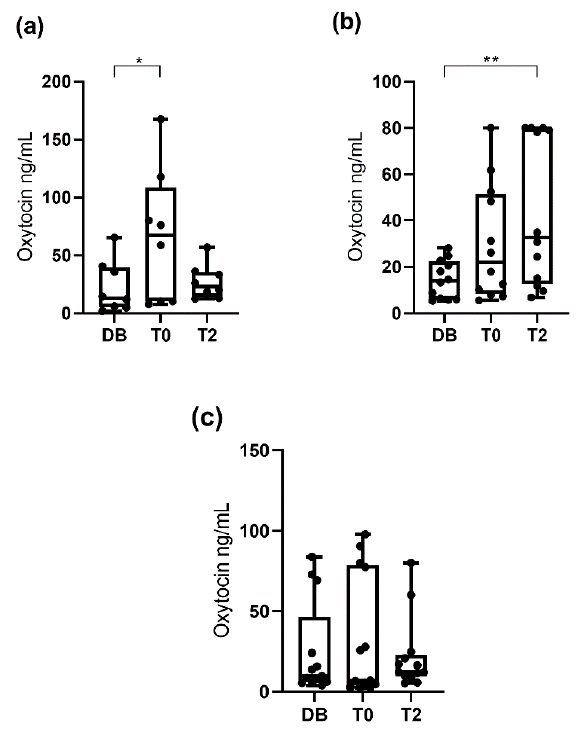
Figure 5. Changes in salivary oxytocin concentrations measured with AlphaLISA polyclonal assay at different times: the day before ejaculate collection (DB), immediately after starting the ejaculation (T0), and two hours after ejaculation (T2). Figure ( a ) shows the data for boars aged 12–24 months and ( b ) and ( c ) those for boars aged 24–36 and aged more than 36 months, respectively. The plots show medians (line within box), 25th and 75th percentiles (boxes), min and max values (whiskers) and individual data points. Asterisks indicate differences between times (** p ≤ 0.01; * p ≤ 0.05).